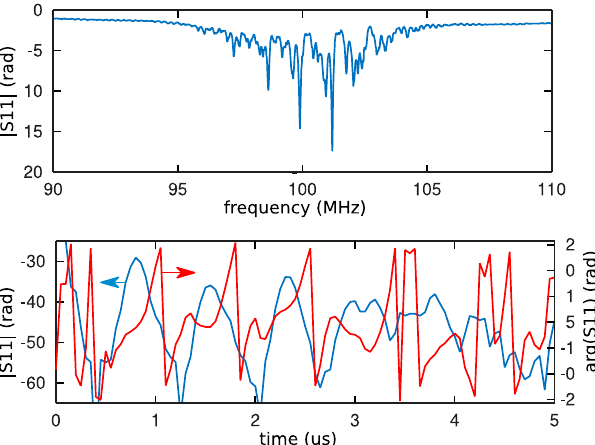
Figure 2. Frequency domain ( top ) and time domain ( bottom ) characterization of the reflective acoustic delay line used in the experiment depicted in this article. While the frequency domain transfer function indicates the spectral characteristics of the probed device, the four echoes as best viewed in the time domain magnitude (blue, bottom, at 0.8, 1.6, 2.4, and 3.2 μ s). Fine acoustic velocity is measured through the phase variation (red) at the delay of maximum magnitude of each echo.